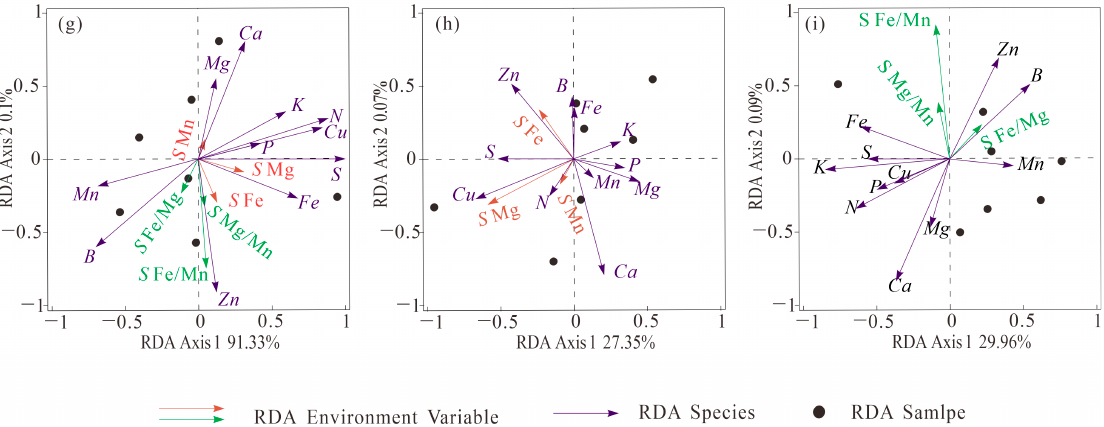
Figure 4. The explanation rate of Fe, Mn, and Mg in the plants and soil. Fe/Mn, Fe/Mg, and Mg/Mn are environmental factors that affecting the plant nutrients and soil’s physical and chemical properties, respectively. ( a – c ): A redundancy analysis (RDA) for plant nutrition. ( d – f ) A redundancy analysis for the soil; ( g – i ). A redundancy analysis for the soil-plant indices.